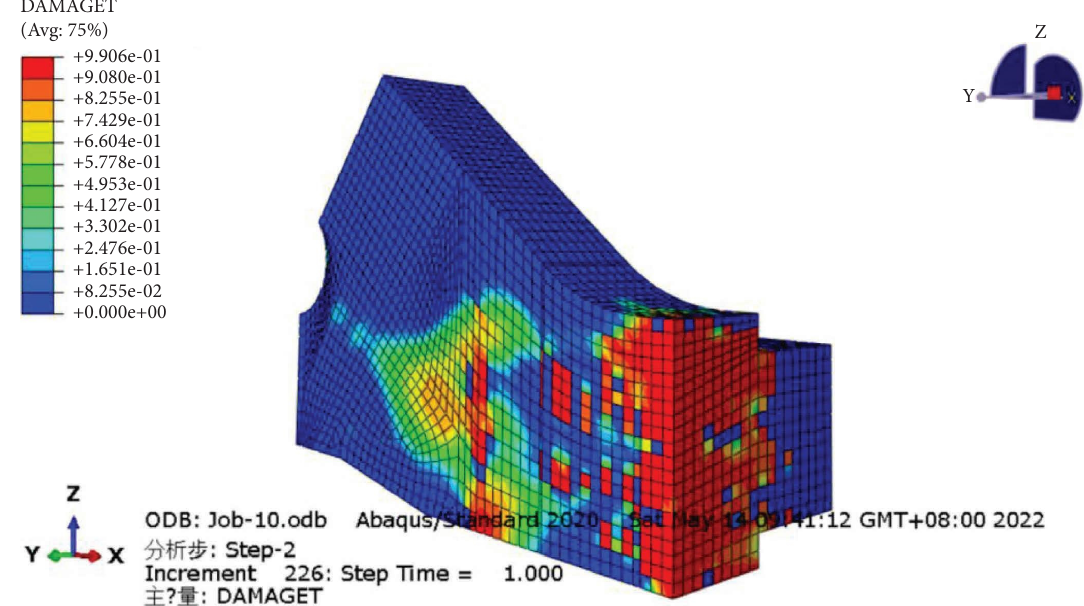
Figure 15: Cloud chart of concrete tensile plastic damage of condition